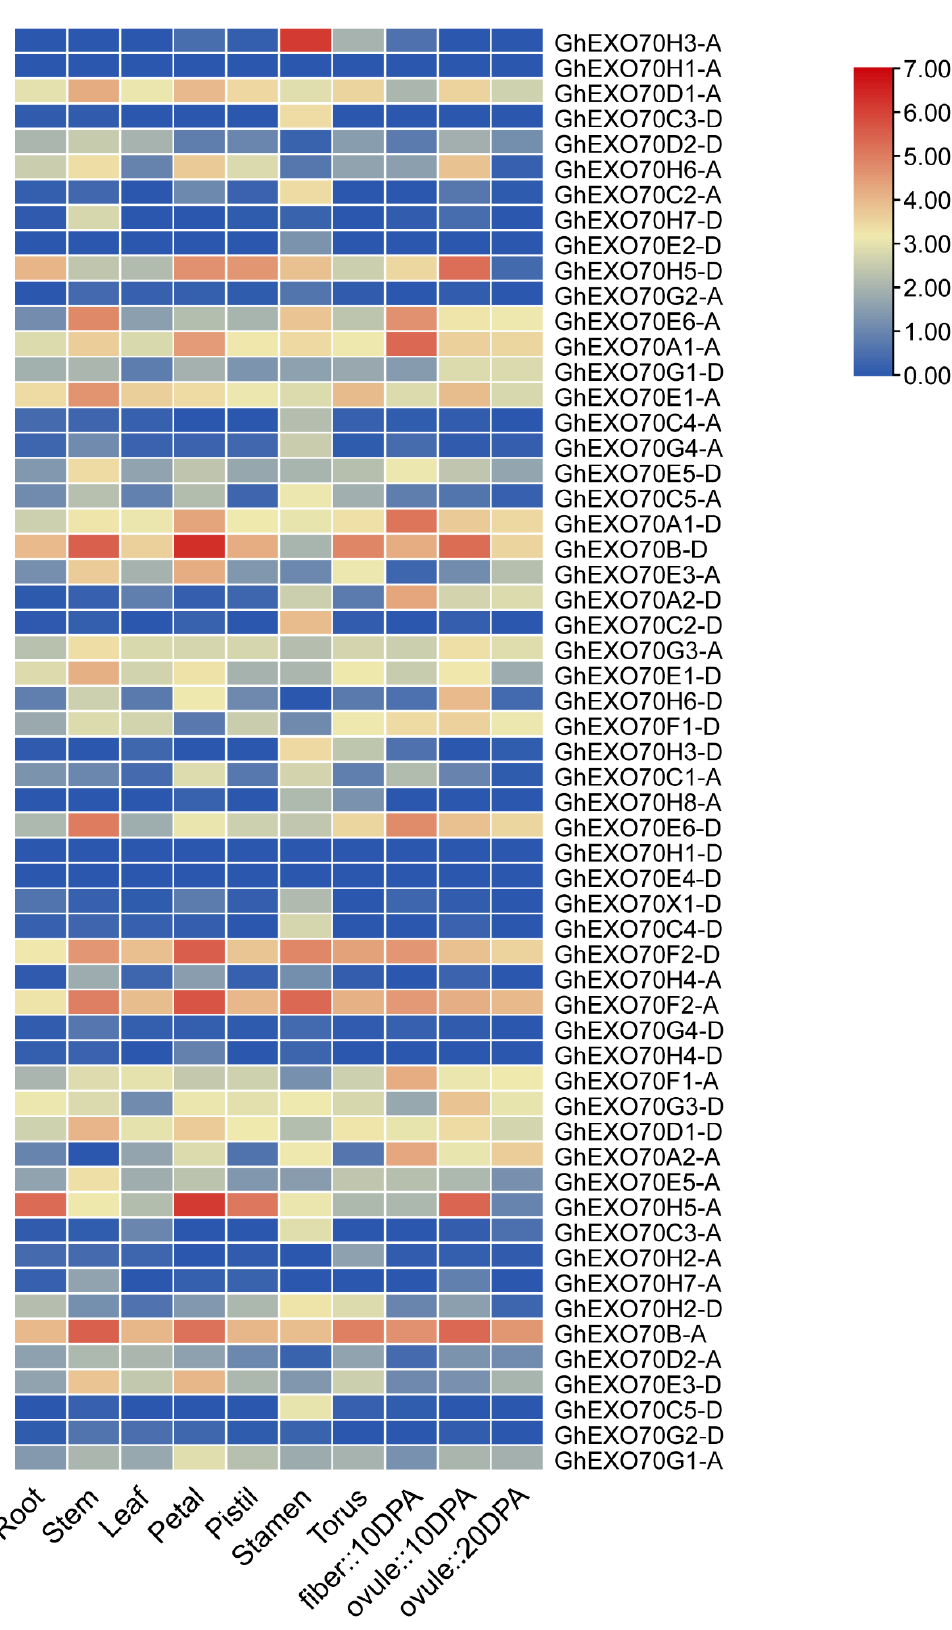
Figure 4. EXO70 family gene expression patterns in different tissues and organs of upland cotton.